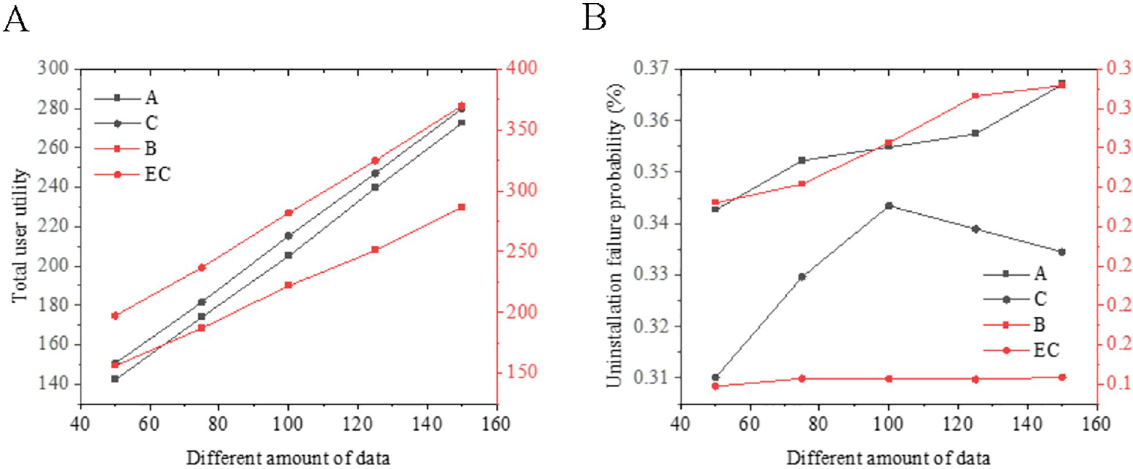
Fig 5. User utility and uninstallation failure under different data volumes.